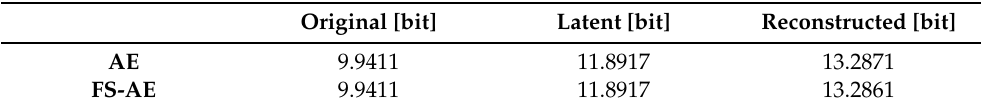
Table 5. Analysis of the information entropy to compressed latent vectors between the AE and FS-AE